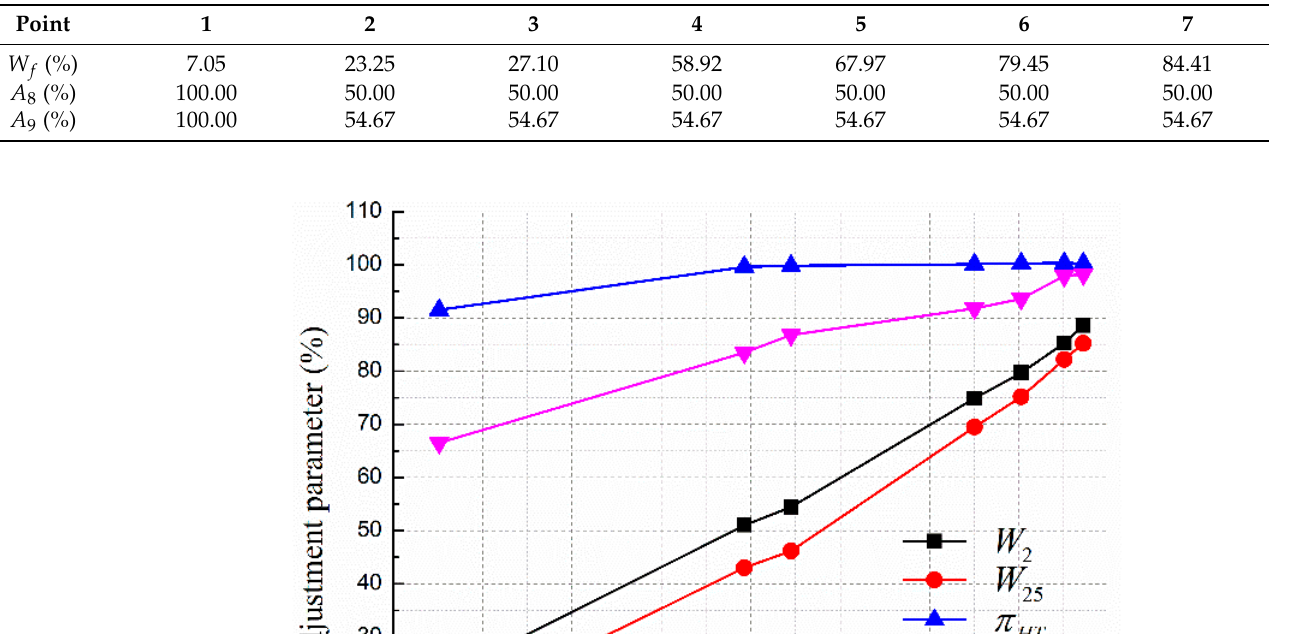
Table 4. Control parameters of the model input.